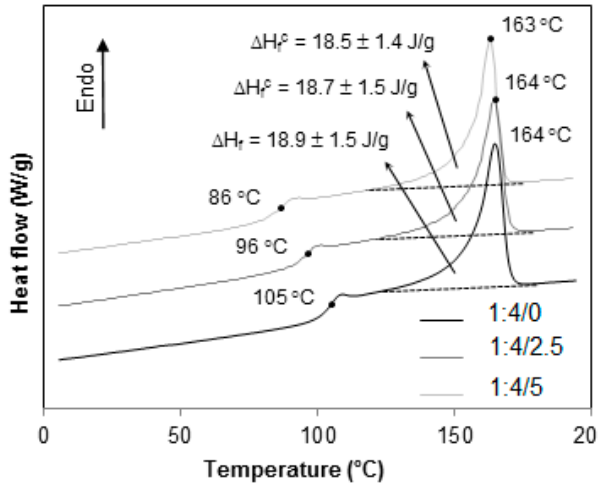
Figure 10. DSC thermograms for 1:4 PP/HIPS blends with 0, 2.5 and 5 phr of CNSL.